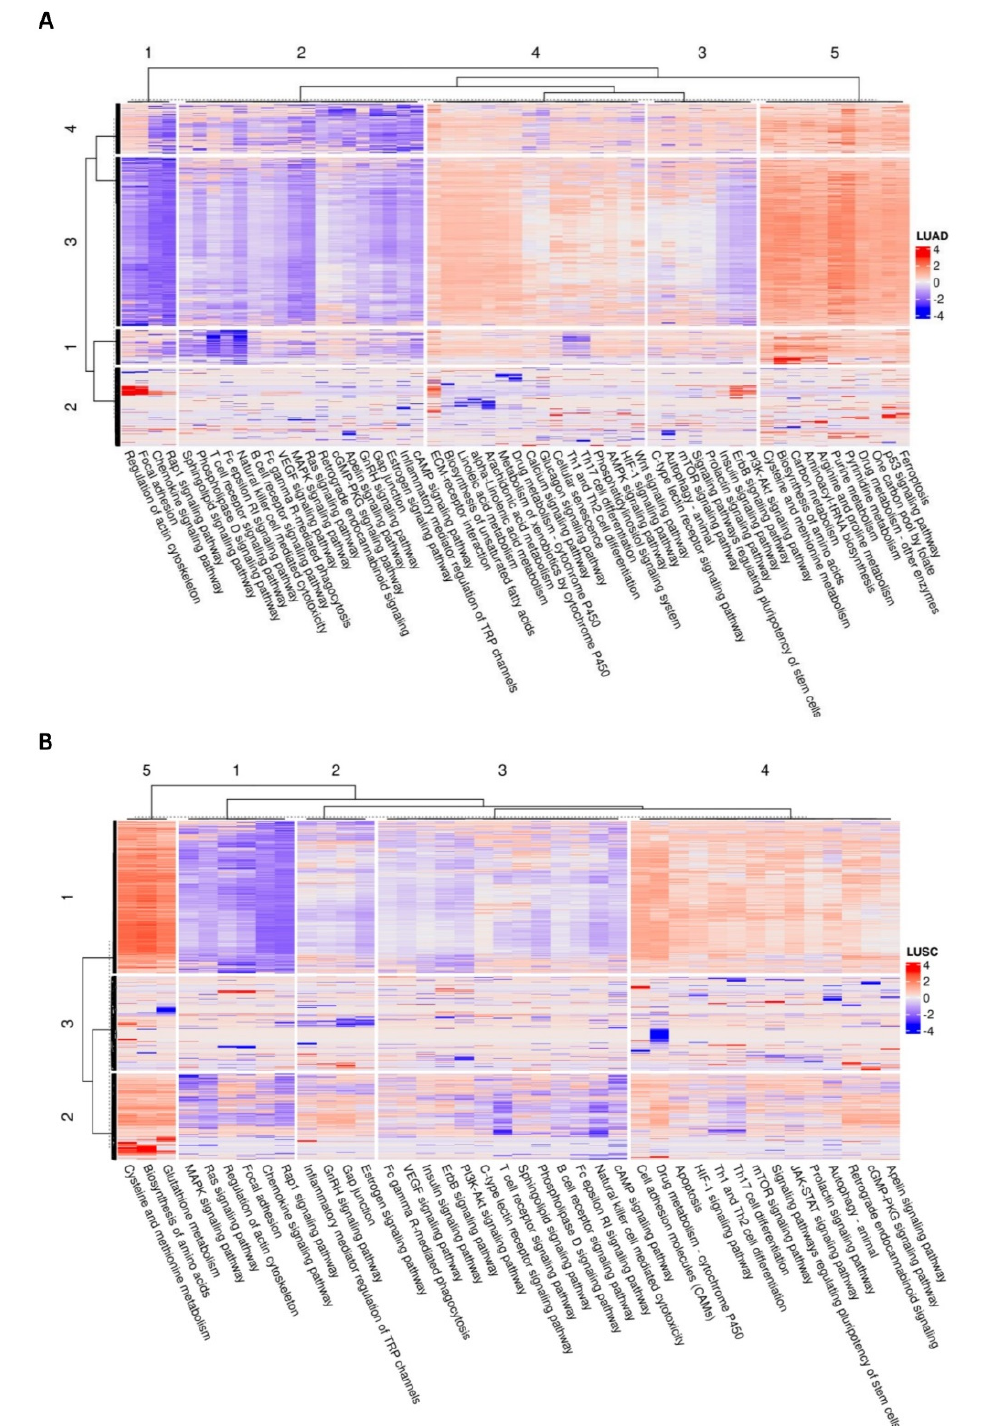
Figure 4. Heatmaps showing the most enriched pathways detected in TCGA − LUAD ( A ) and TCGA − LUSC ( B ) after the HERV − specific pathway analysis performed by MITHrIL. In more detail, the value reported in the heatmap are the corrected accumulators generated by MITHrIL when it computed the perturbation scores, and both columns (pathways) and rows (differentially expressed HERVs) were clustered using the Spearman correlation distance.